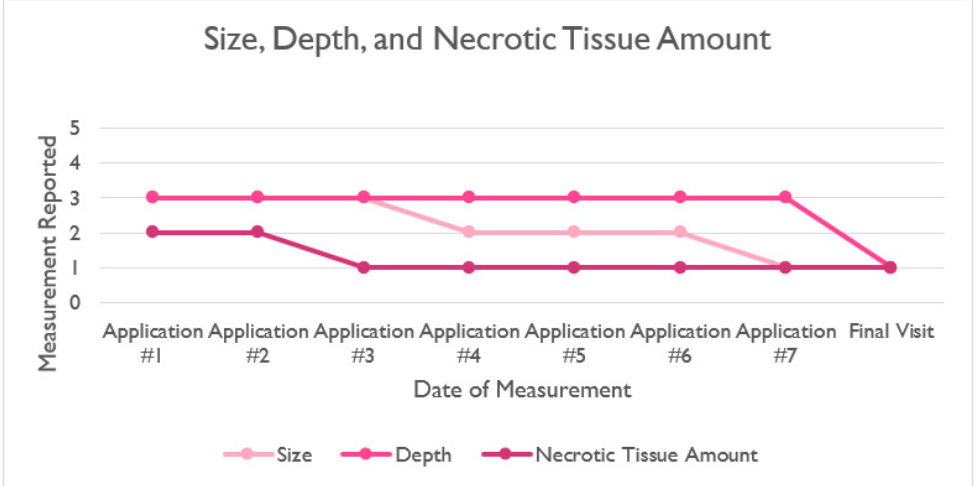
Figure 2. Progression of size, depth, and necrotic tissue amount in DFU over 49 days. Reference Appendix B for the key correlated to each value.